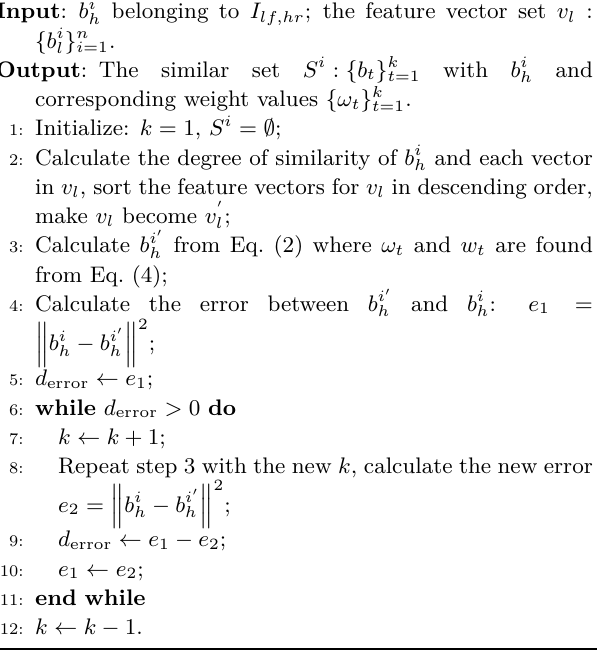
Algorithm 1 Adaptive k NN search